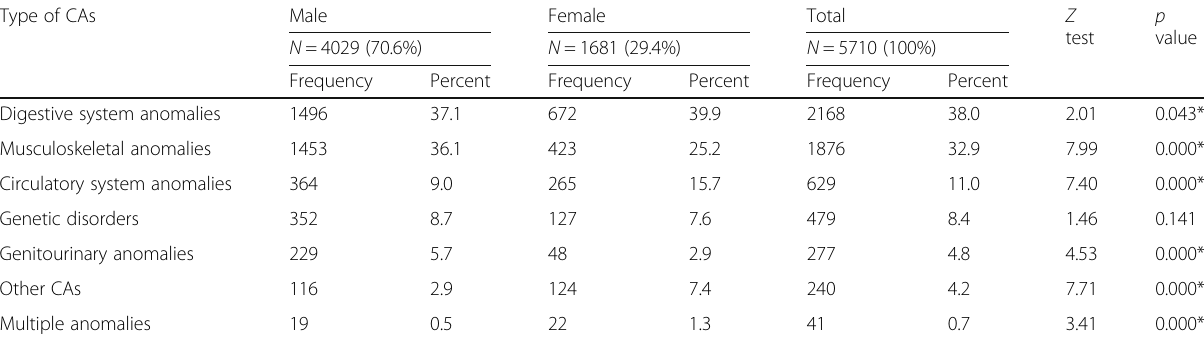
Table 2 Frequency of different types of CAs by sex throughout the studied years in the Pediatric University Hospital, Alexandria, Egypt, 2010 – 2015